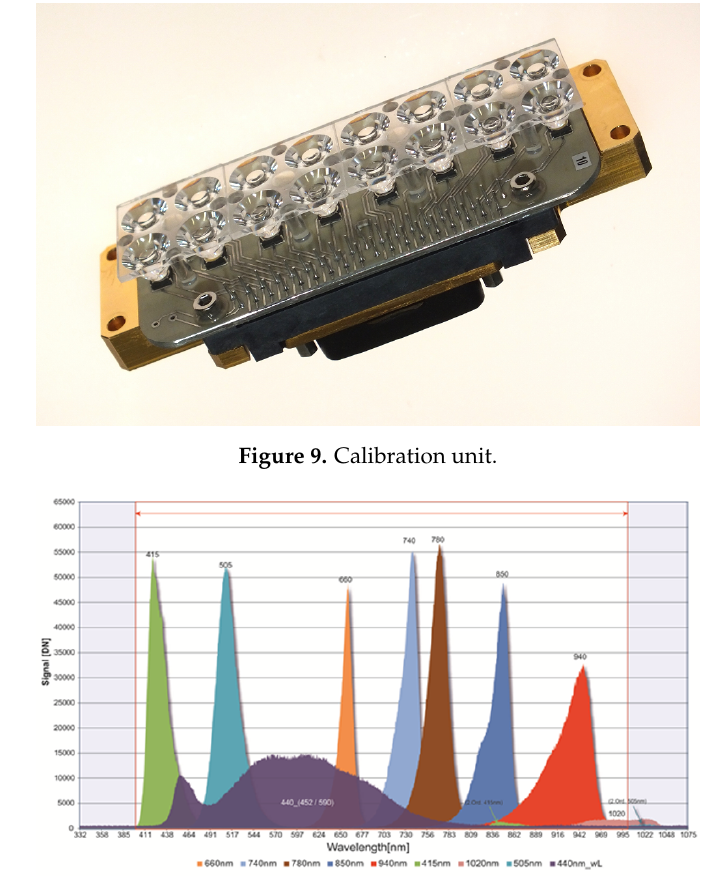
Figure 10. Spectrum of DESIS calibration unit using different LEDs.